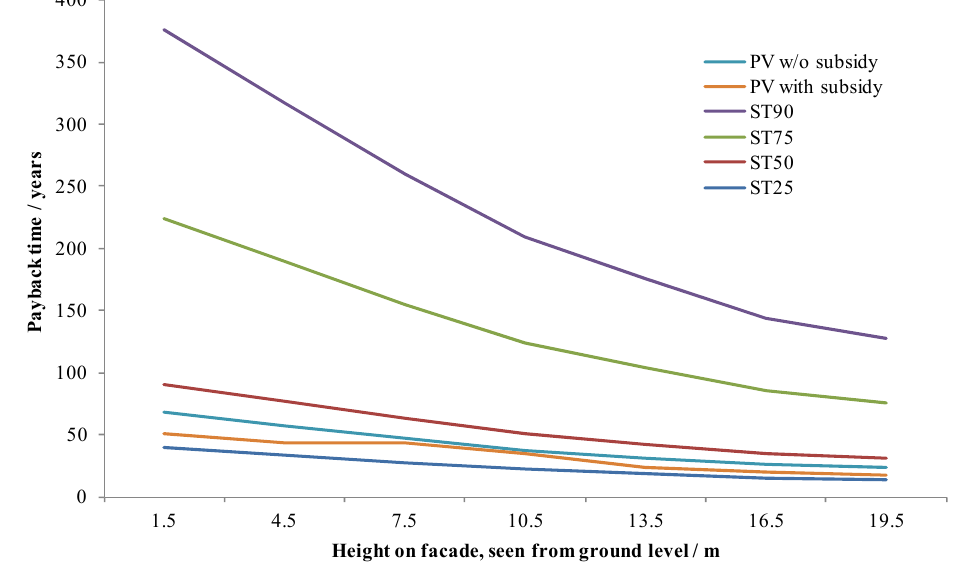
Figure 8. Payback time as a function of